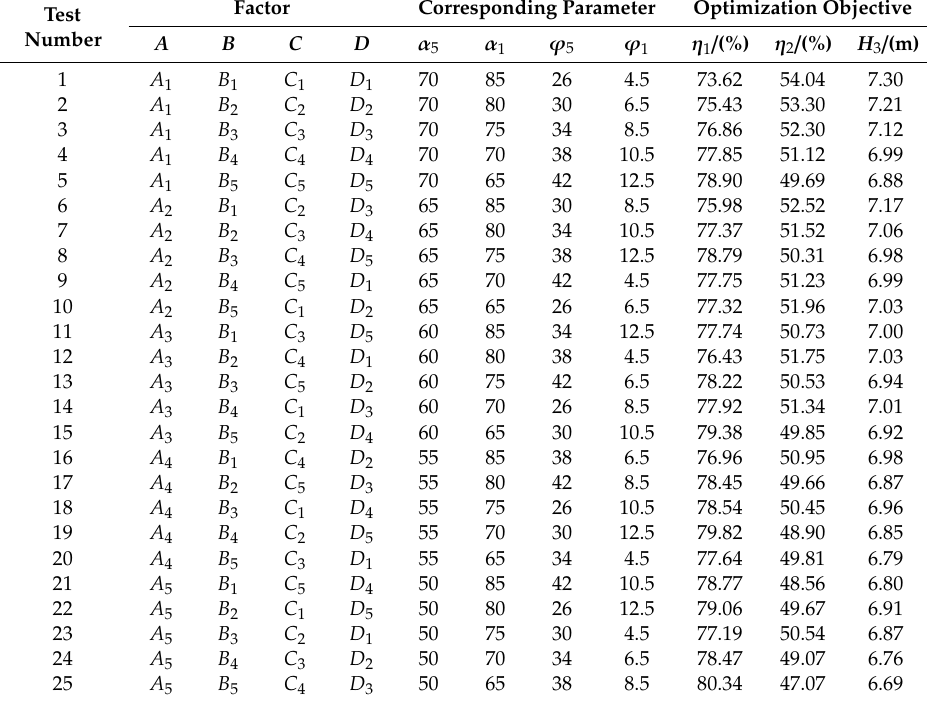
Table 3. Orthogonal test